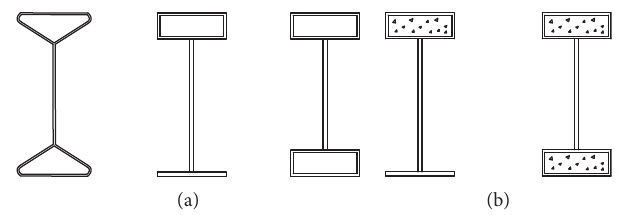
Figure 1: Girders with tubular flange. (a) Hollow tubular flange. (b) Concrete-filled tubular flange.